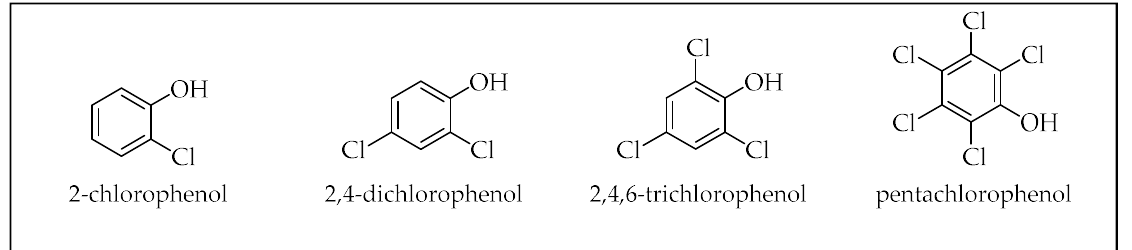
Chart 1. Common priority pollutant phenols.